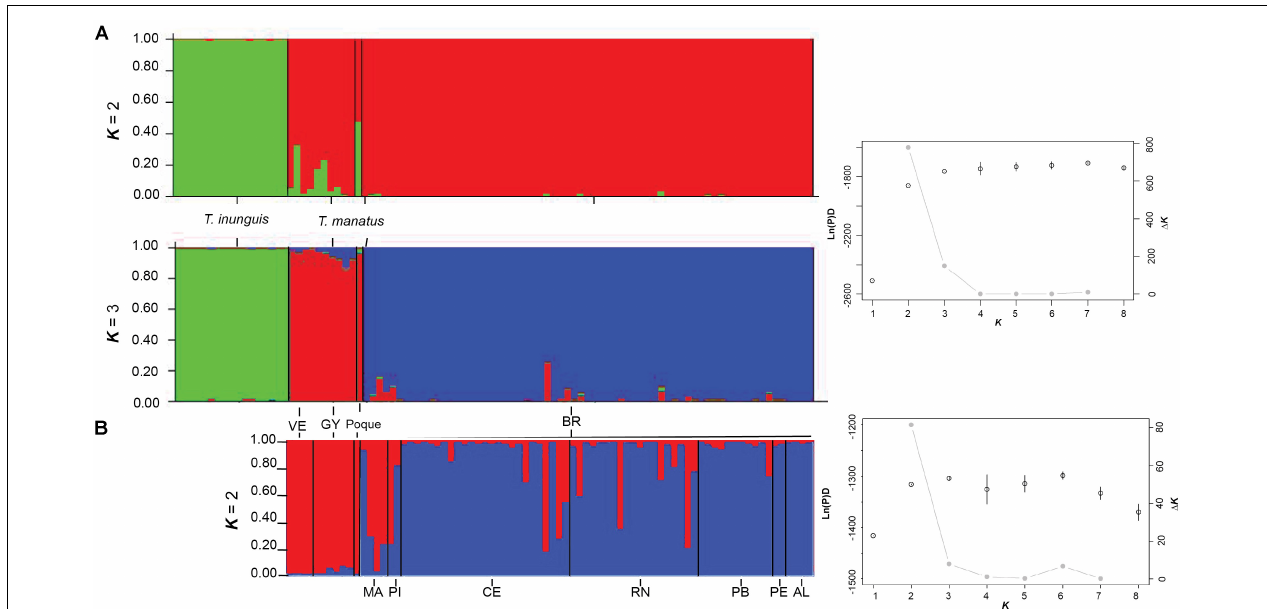
FIGURE 2 | Hierarchical bar plots that indicate population structure found in microsatellite DNA. Populations are differentiated by color with each line indicating an individual sampled and represent Venezuela (VE), Guyana (GY), and Brazil (BR). Brazilian state abbreviations are described in the main text. Each solid black line indicates the extent for that sampling location. Bar plots represent the S TRUCTURE program hypotheses of K = 2 and K = 3 populations (A) , when all individuals sampled were analyzed. Substructure among the eastern Antillean manatees only is represented and hypothesized as two populations ( B , K = 2). Dotted line on plot (B) displays the threshold of q > 0.8 to indicate assignment of an individual to a specific population. Each line representing “Poque” is marked with an asterisk (*) in all q plots. Results from Structure Harvester Software are presented to the right of the corresponding q plots. The Harvester plots visualize the mean estimate ln(P)D as open circles on the left y -axis. Black lines through the open circles represent standard deviation among the individual iterations for each K . The gray dot-line plot visualizes the (cid:49) K values on the right y -axis. The value K on the x -axis indicates the number of clusters